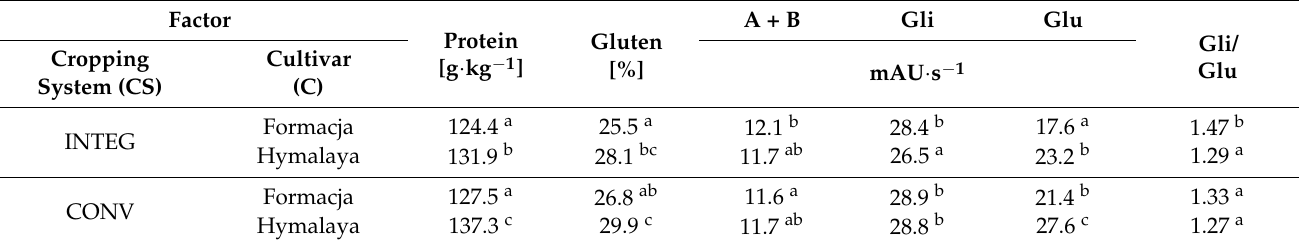
Table 4. Effect of cropping system and cultivar on the content and composition of